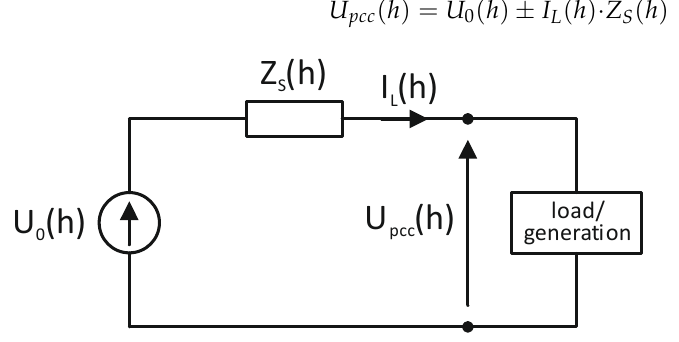
Figure 1. Simplified power system model with non-linear load [22]. The voltage at the point of connection comprises the sum of the background distortion U 0 ( h ) (caused by the non-linear loads present in the power system) and the distortion caused by the analysed load or generator I L ( h ) · Z S ( h ). Depending on the phase shift of